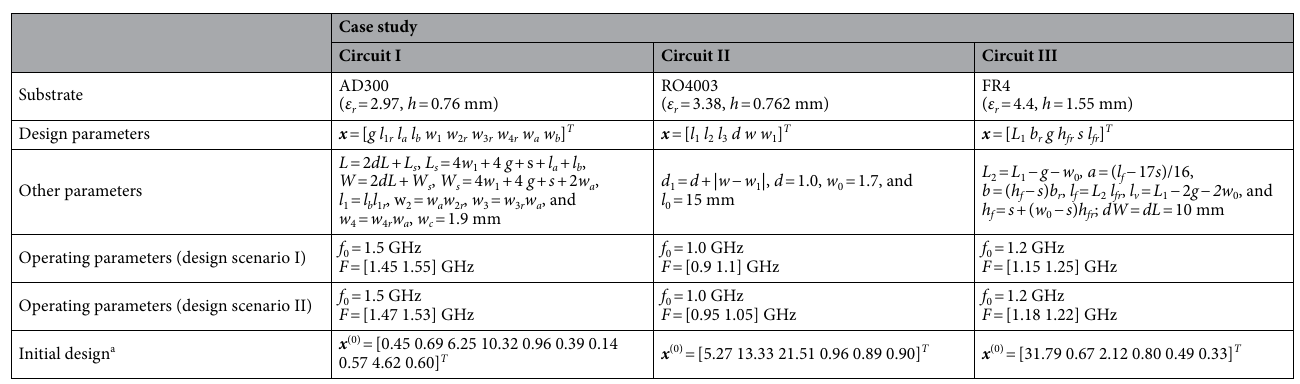
Table 1. Benchmark microwave components. a Initial design obtained by optimizing the circuit for best matching/isolation within the frequency range F , under equal-power-split